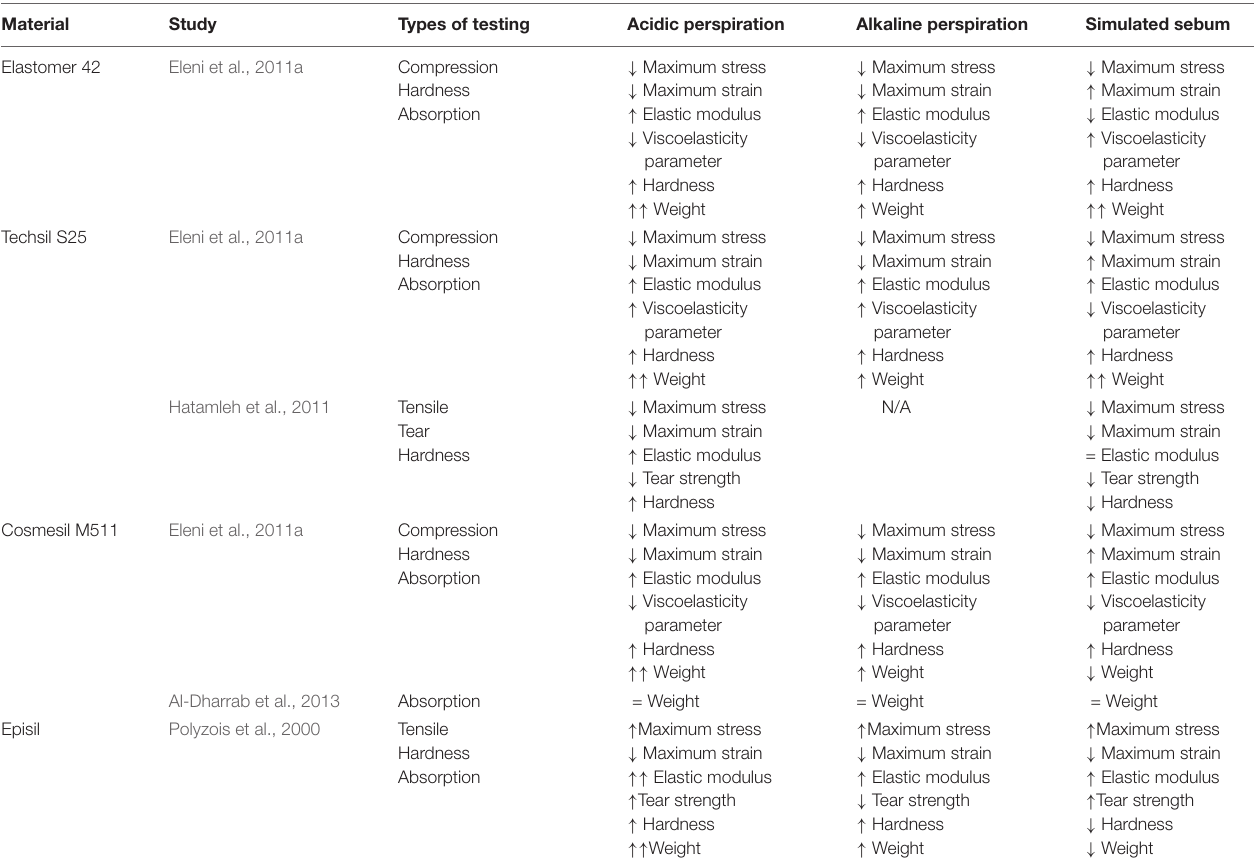
TABLE 2 | Effect of skin secretions on different silicone